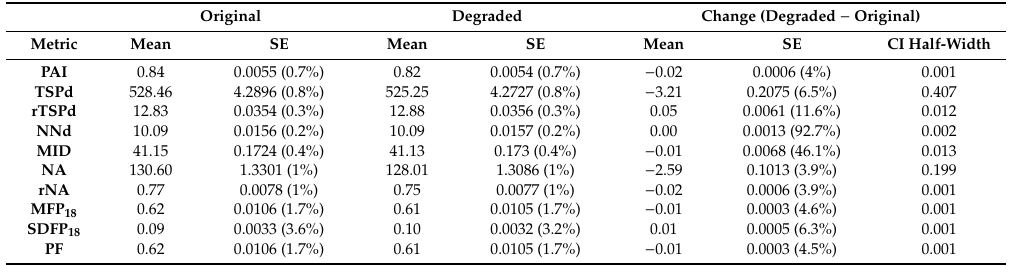
Table 2. Plot-based mean and precision values of metrics and change described in Table 1 and Equations (4) and (5), calculated for the SC study area. Entries consist of means, absolute and relative (%) standard errors (SE), and, for change, the 95% confidence interval half-widths (SE*1.96). Estimates are from the original photointerpretation (PI) dataset (Original); the same plots, but with 1% random forest loss applied (Degraded); and the mean di ff erence (Degraded − Original). PF, which is not a fragmentation metric included in Table 1, is the population-level estimate of forest proportion. Original